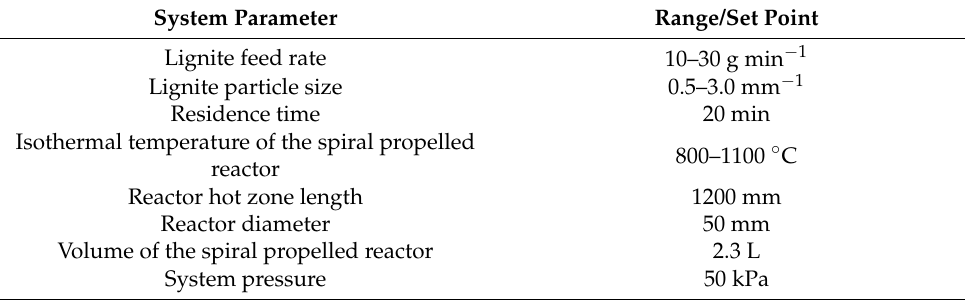
Table 2. The design parameters of the experimental apparatus.